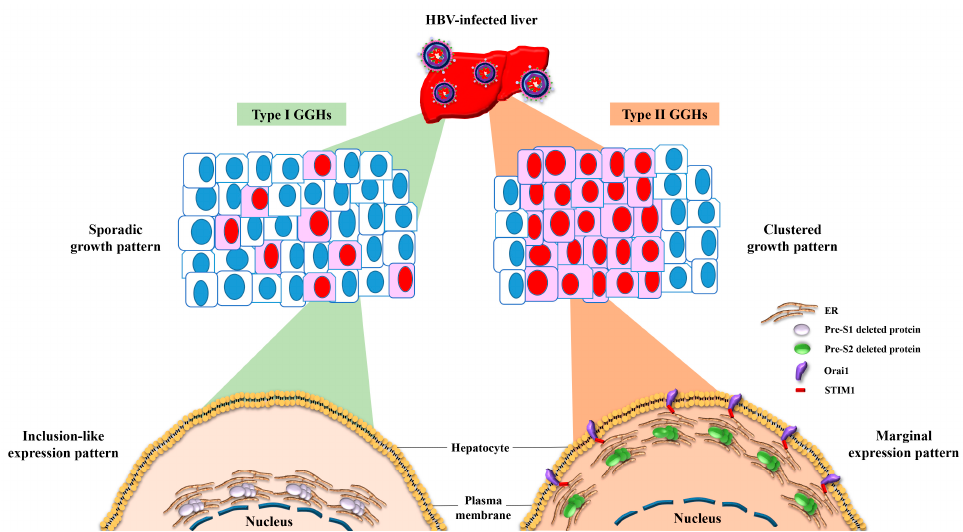
Figure 3. Schematic representation of the growth patterns of GGHs and the expression patterns of HBV pre-S deleted proteins. In the liver tissues of patients with chronic HBV infection, two distinct types of GGHs (type I and type II) are identified as HBV-infected hepatocytes that express pre-S1 and pre-S2 deleted proteins, respectively. Type I GGHs display a scattered or sporadic growth pattern and express pre-S1 deleted proteins in a globular or inclusion-like pattern due to the accumulation of pre- S1 deleted proteins in the ER, whereas type II GGHs display a clustered growth pattern and express pre-S2 deleted proteins in a marginal pattern due to the accumulation of pre-S2 deleted proteins in the ER followed by STIM1-and Orai1-mediated connection of the ER and plasma